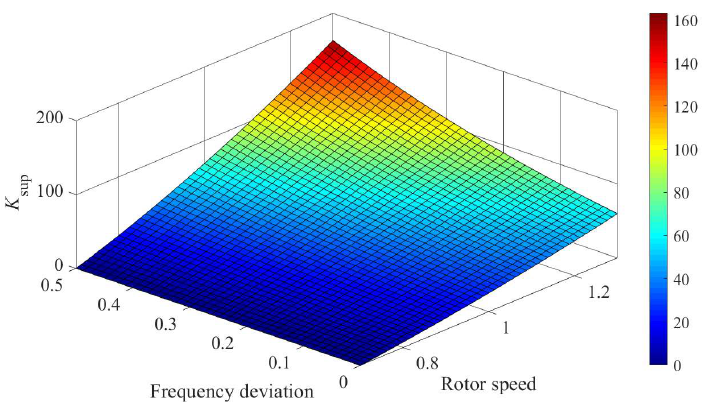
Figure 8. K sup for the proposed IRI scheme during the IRI period.